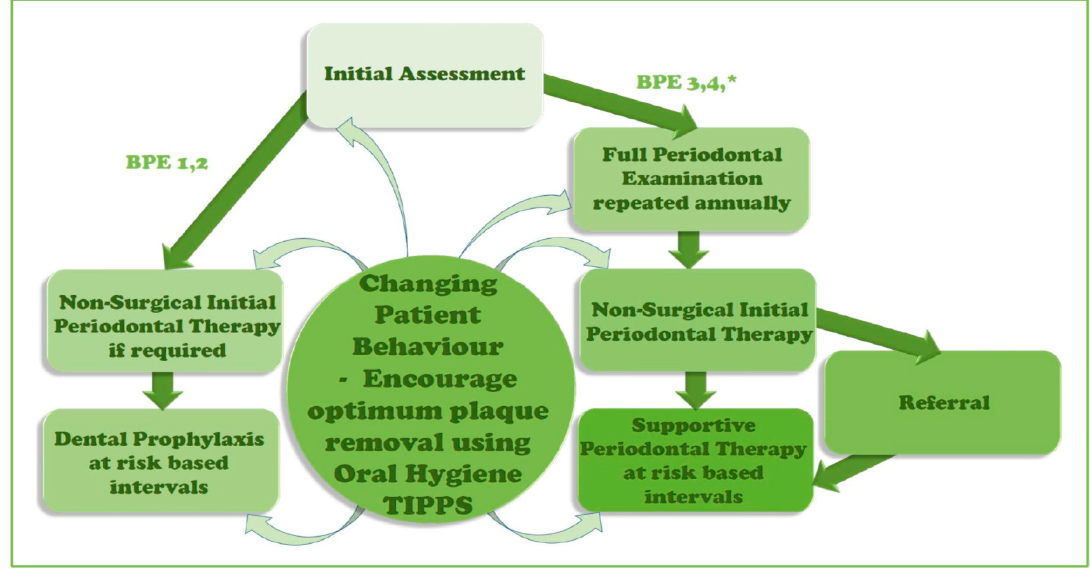
Figure 17. The scheme of the main elements of the prevention and treatment of periodontal diseases in primary care.